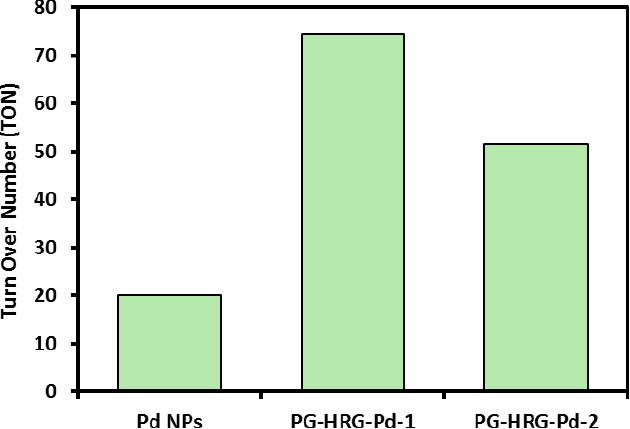
Figure 9. Graphical illustration of comparative turn over number (TON) values.